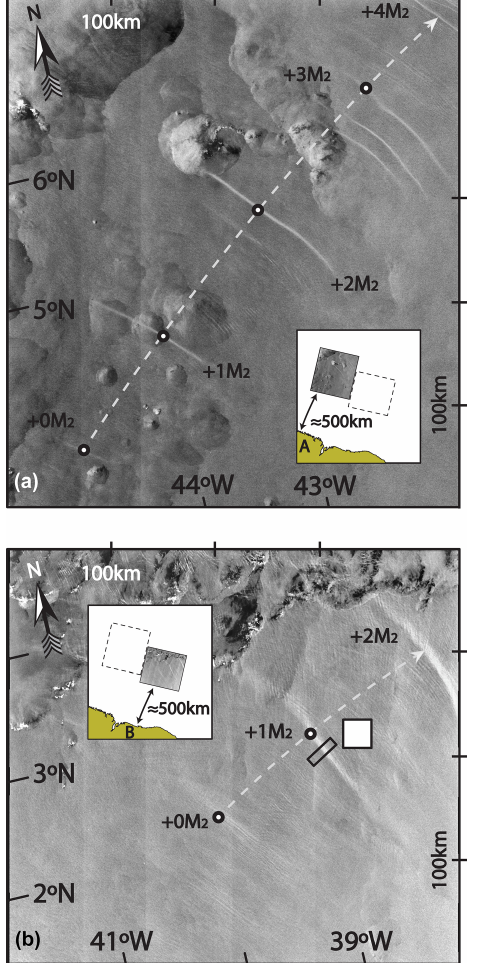
Figure 3. (a) Subset of a SAR image dated 2 February 2011 (ac- quired at 12h47m) showing ISW packets emanating from location A, and labelled sequentially from 0M 2 to 4M 2 (with 4M 2 being only partially imaged). An inset shows the image location with re- spect to the coastline, and the dashed line shows the location of Fig. 3b for comparison. (b) As in top panel but for a SAR im- age dated 6 September 2004 (acquired at 12h25m) and showing ISWs packets emanating from location B. The black rectangle and white-filled square are examples of a radar backscatter transect and mean unperturbed background. A north-pointing arrow and distance scales are added on the top and right-hand sides of both images.